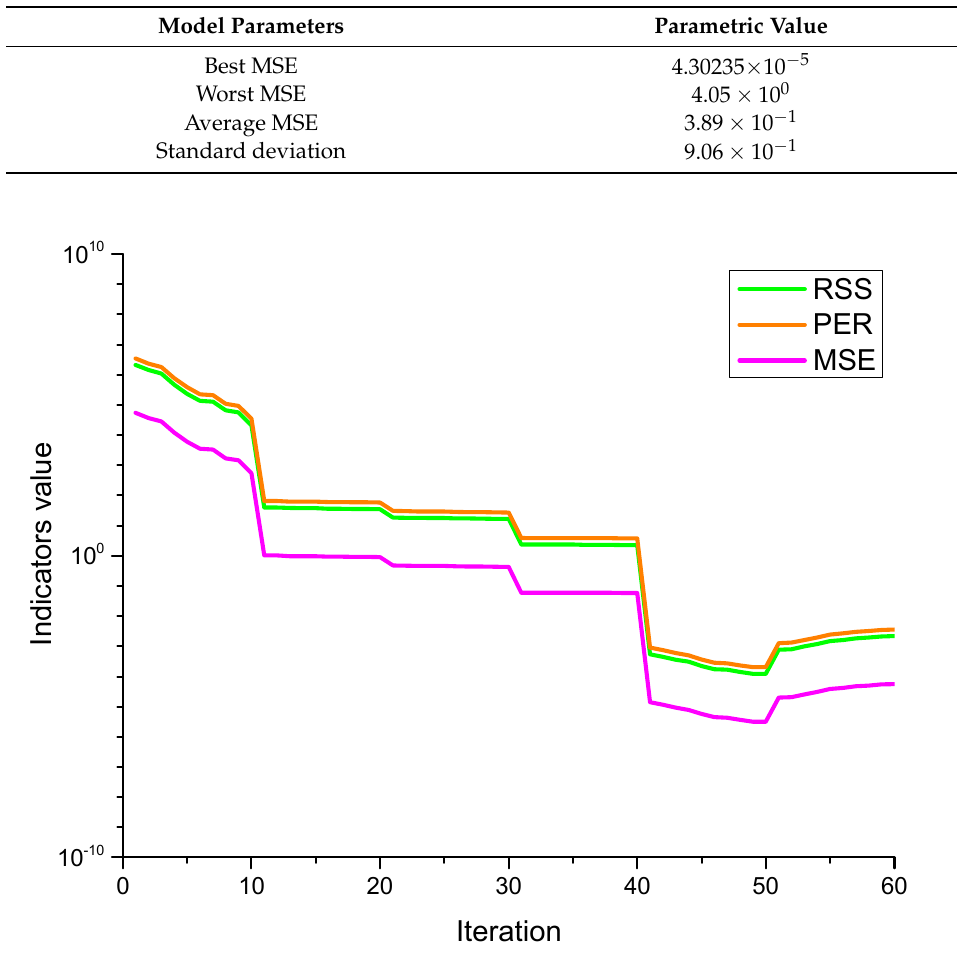
Figure 13. Searching agents for case study-II.